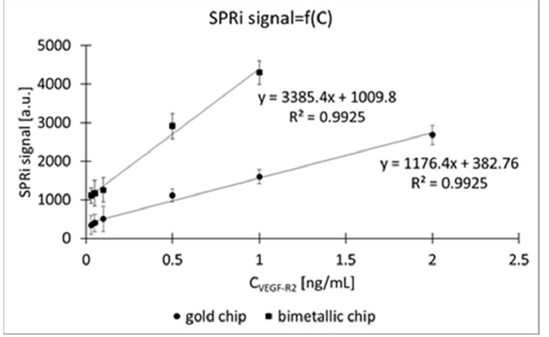
Figure 4. Working range of the calibration curves. Ligand concentration was 20 ng/mL, pH = 7.40.